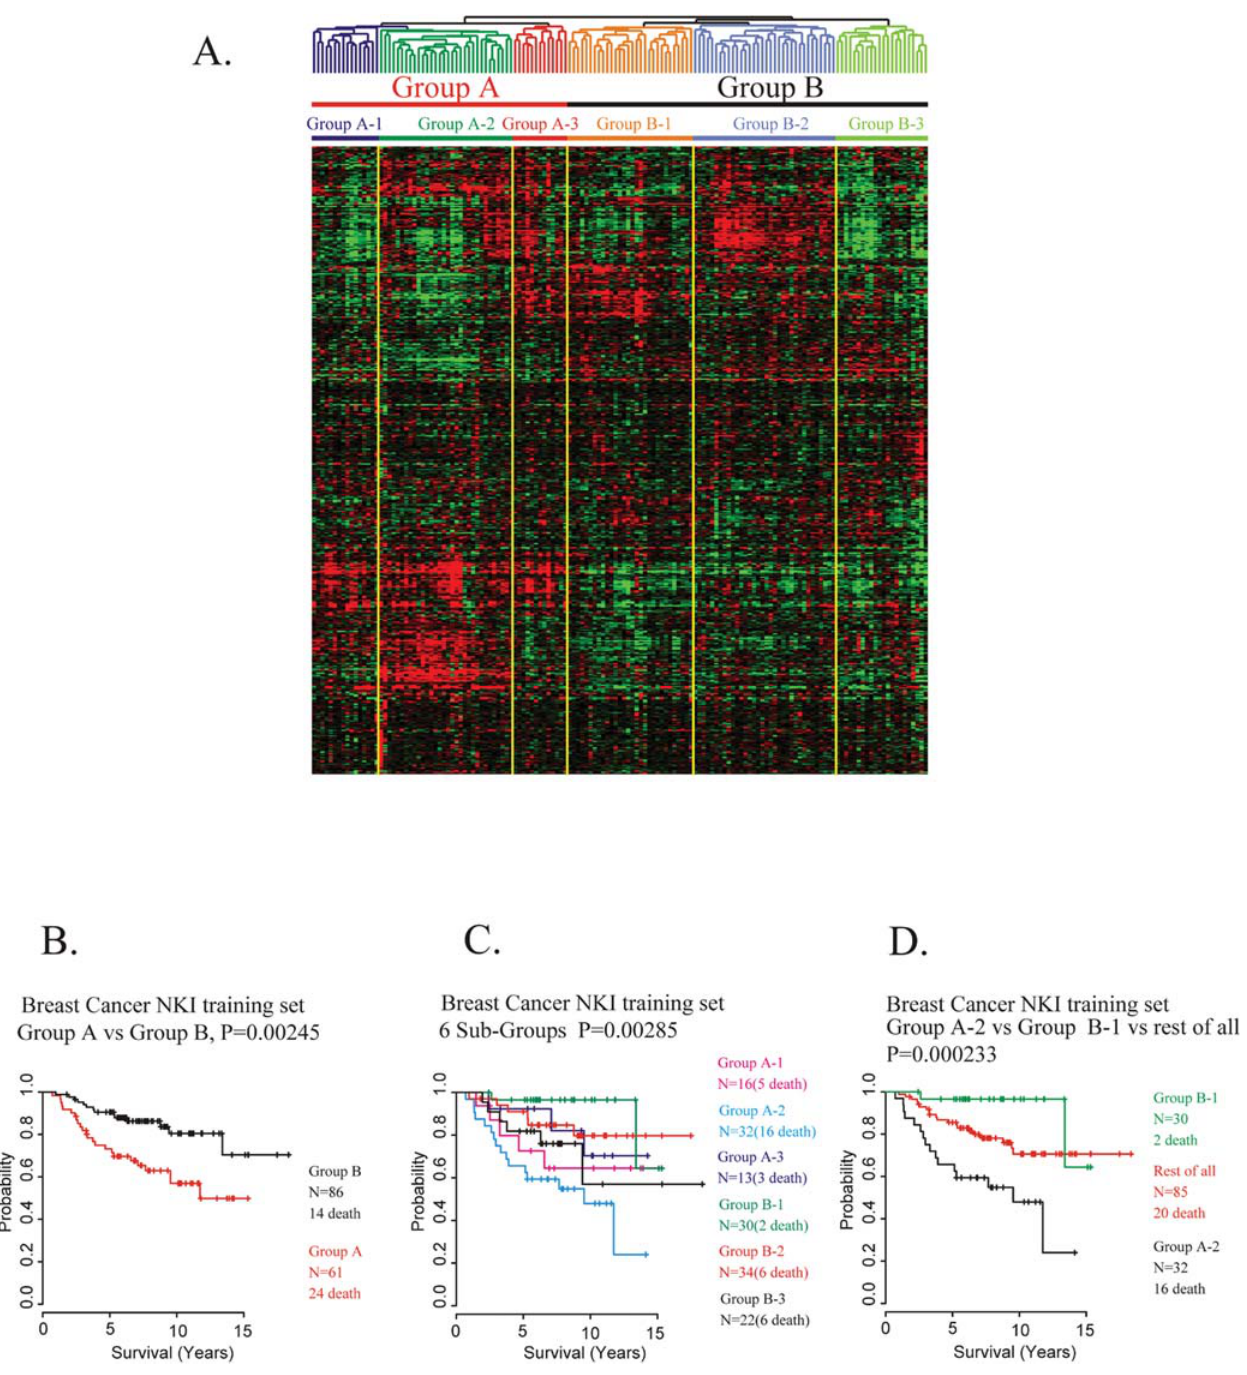
Figure 2. Construction of human breast cancer patients’ prognosis prediction models and evaluation of outcomes A. Unsupervised cluster analysis of NKI training data set (147 samples). It generated two main clusters and six sub-clusters of patients. B. Kaplan-Meier survival analysis of the two main clusters (Group A and Group B). C. Kaplan-Meier survival analysis of the six subclusters (Group A1–A3 and Group B1– B3). D. Kaplan-Meier survival analysis of two sub-clusters (Group A2 and Group B1) showing WORST and BEST prognosis and one group that includes all the others. doi:10.1371/journal.pone.0000145.g002 three independent prediction models for the prediction of approach. However, we felt that including all 6, followed by patients subtype as good prognosis vs. bad prognosis (predictor 1), BEST prognosis vs. not BEST (predictor 2), and WORST prognosis vs. not WORST (predictor 3). All 6 algorithms yielded very similar results, showing the reliability and robustness of our of outcomes.